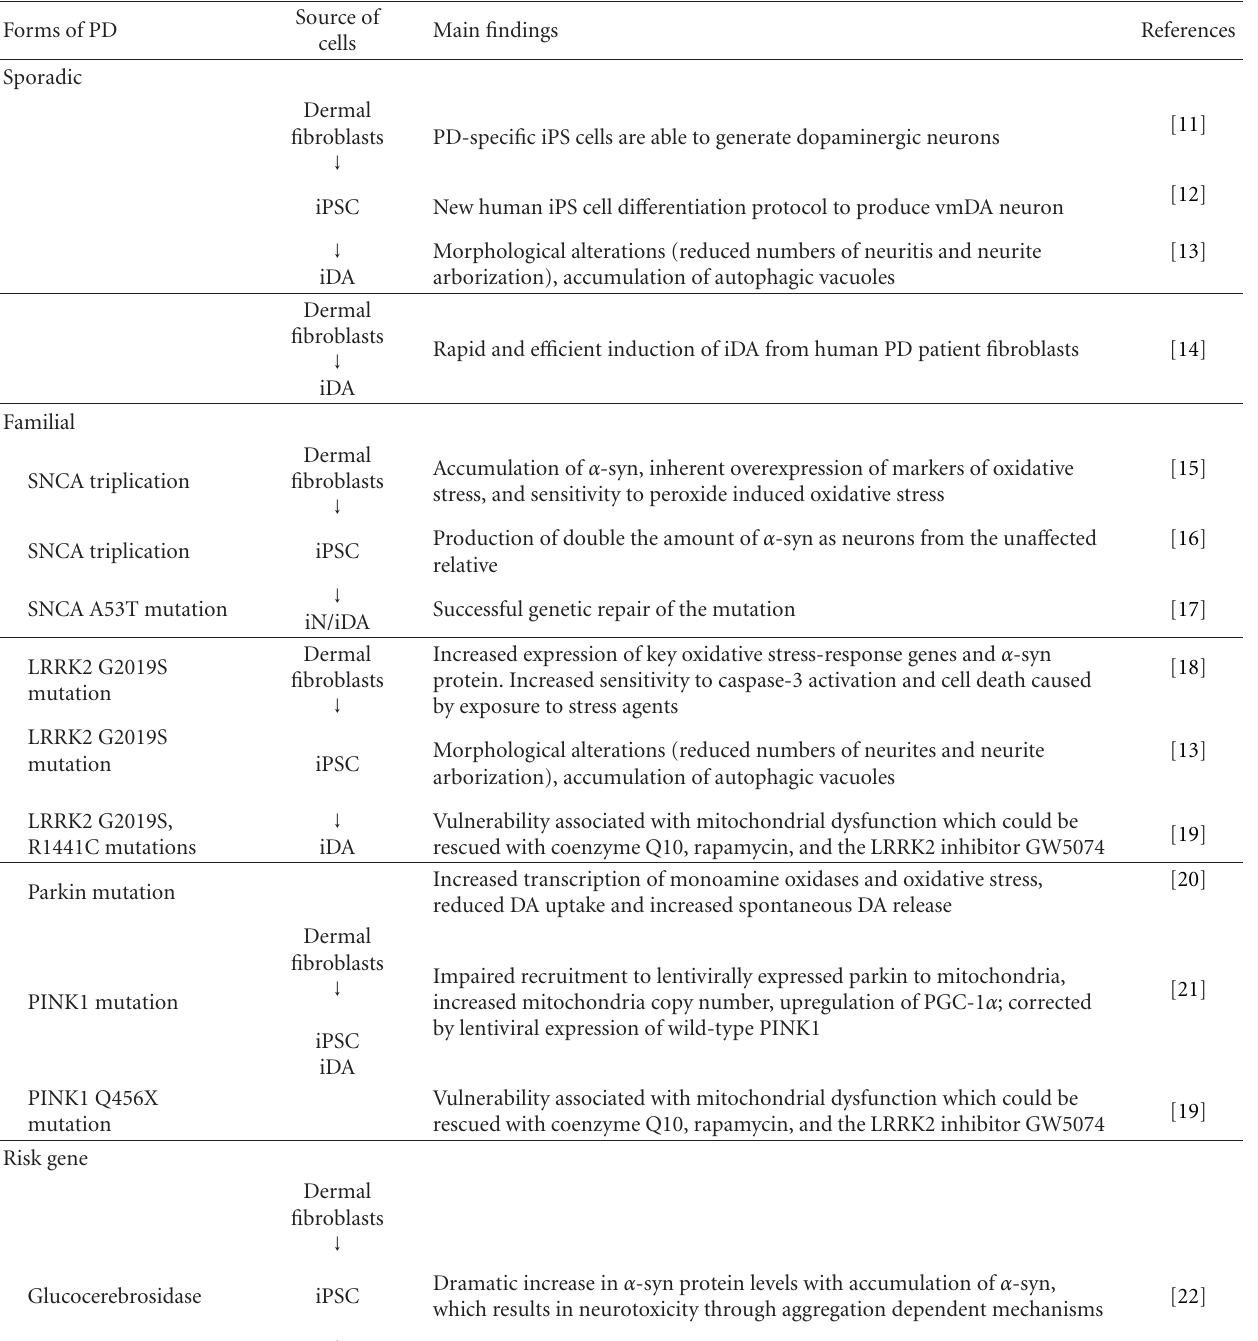
Table 1: Summary of studies that have used dermal fibroblasts from PD patients to model the disease. Forms of